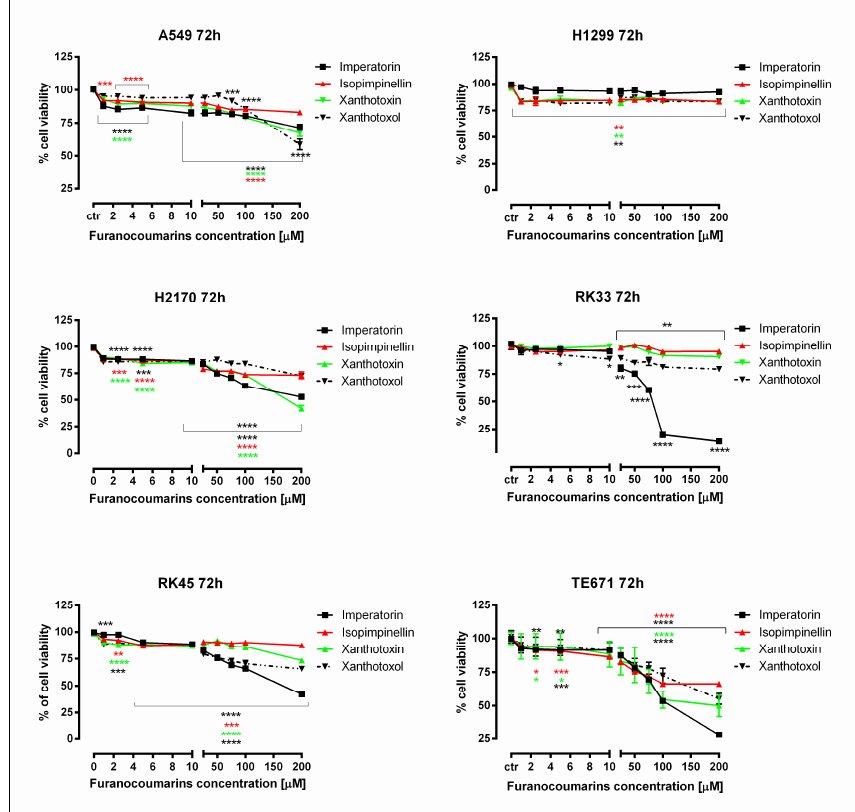
Figure 1, various cancer cell types displayed differential responses when treated with furanocoumarins.